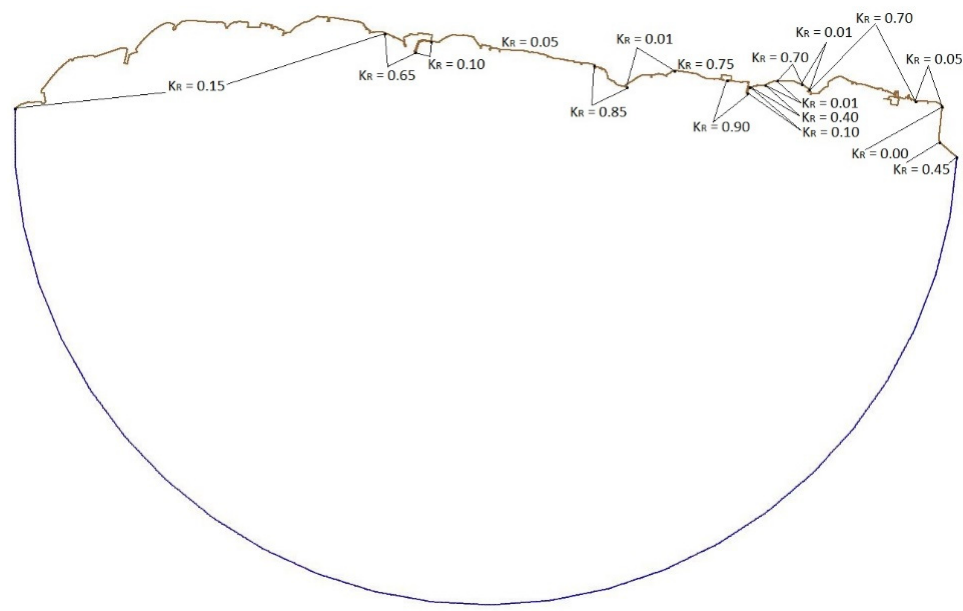
Figure 5. Shoreline reflection coefficient along the